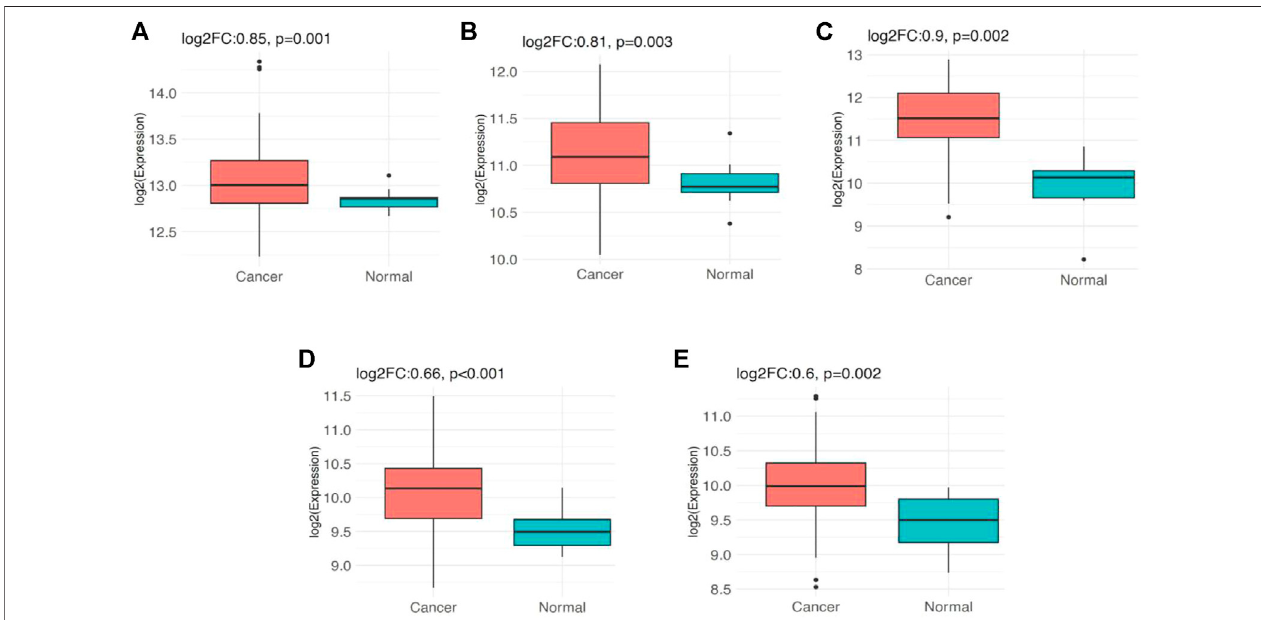
FIGURE11| Expressionpatternofthe PSMC genesinLUADtissues( n =57)andadjacentnormallungtissues( n =11)obtainedfromtheGSE116959dataset: (A) PSMC1 , (B) PSMC2 , (C) PSMC3 , (D) PSMC4 , and (E) PSMC5 . All the PSMC swerefound to be signi fi cantly overexpressed in LUADtissuescompared tothe adjacent normal lung tissues (log2FC: > 0.59, p <